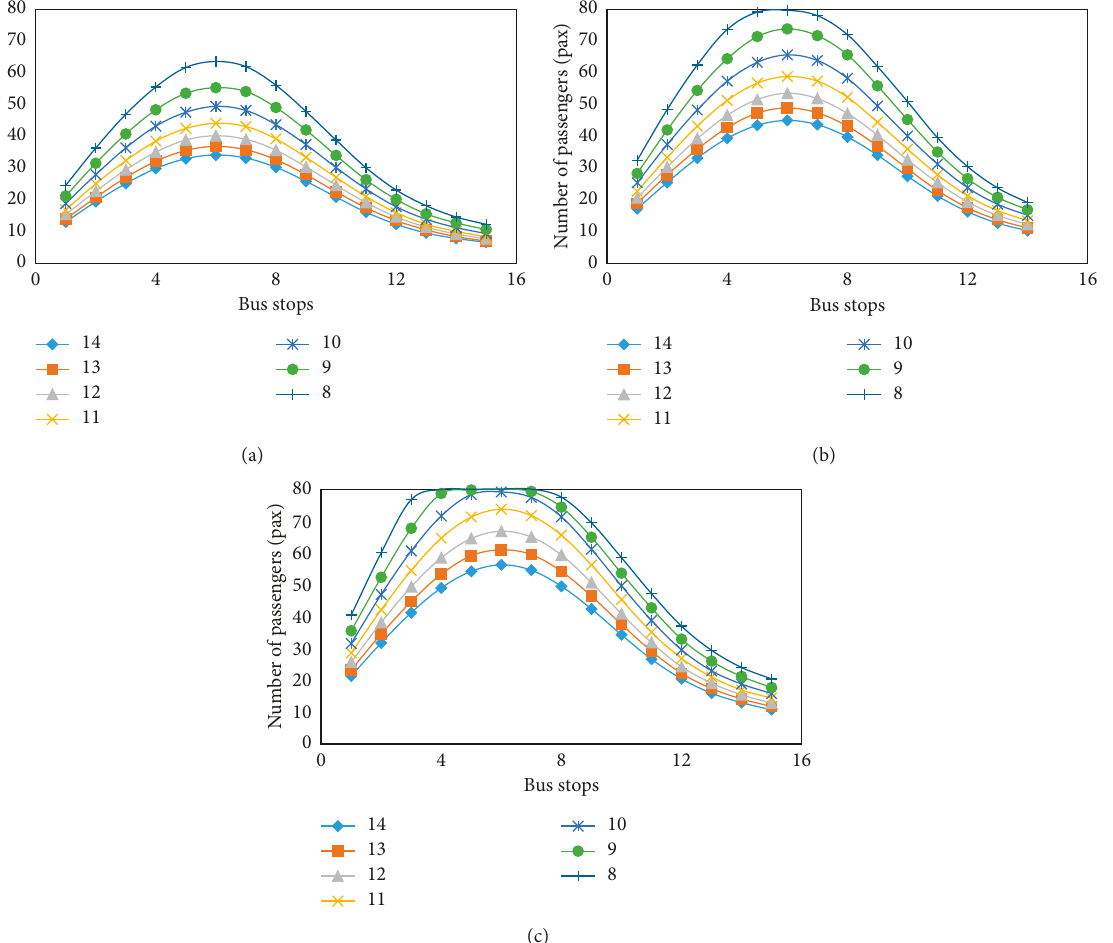
Figure 9: Number of passengers on buses at each bus stop. (a) Group r1. (b) Group r2. (c) Group